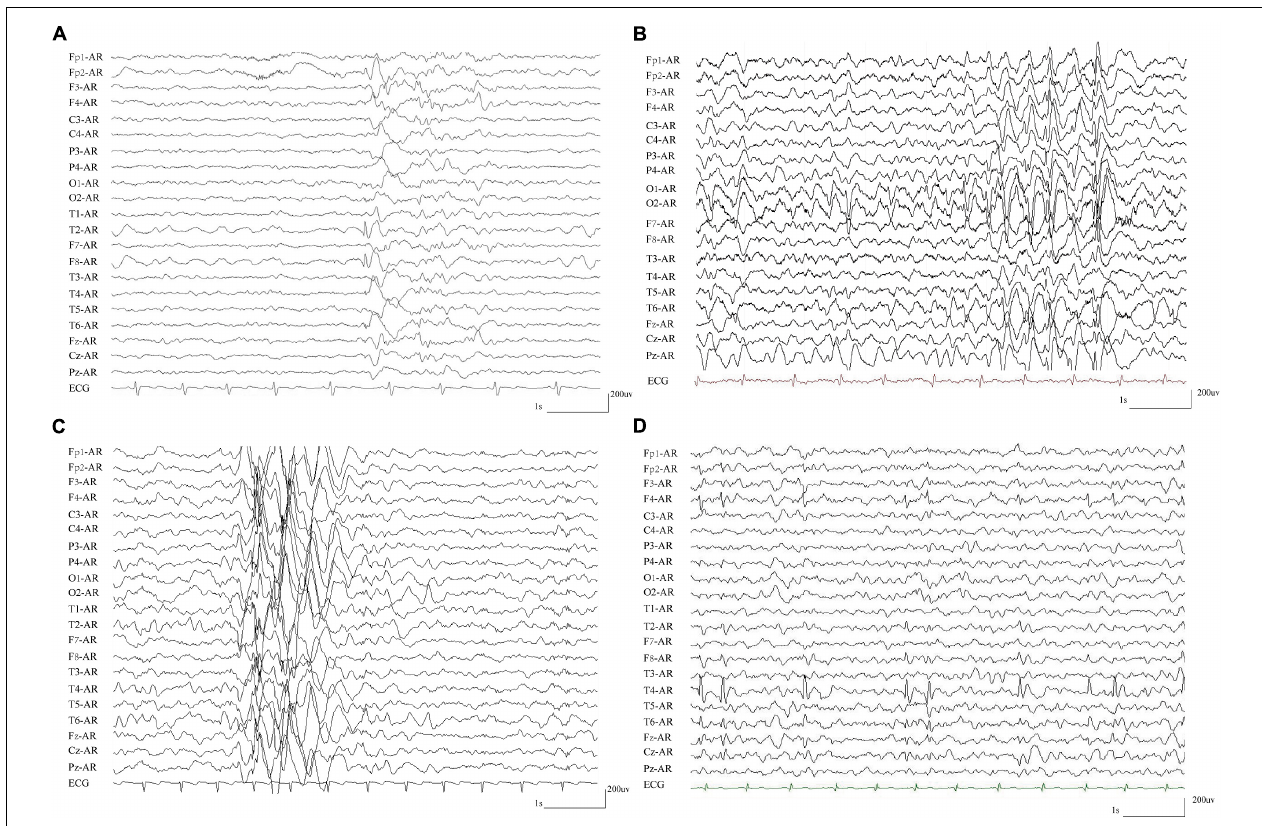
FIGURE 4 | Representative EEG recordings from patients with compound heterozygous PKD1 mutations. (A) Interictal EEG in case 3 showed spike-slow and slow waves in the right anterior frontal and temporal regions. (B) Interictal EEG in case 4 showed spike-slow and slow waves in the bilateral occipital lobes and diffused spike-slow waves. (C) Interictal EEG in case 5 showed irregular diffused spike-slow waves with predominance in the right areas. (D) Interictal EEG in case 8 showed spike-slow waves in the right frontal and temporal regions.